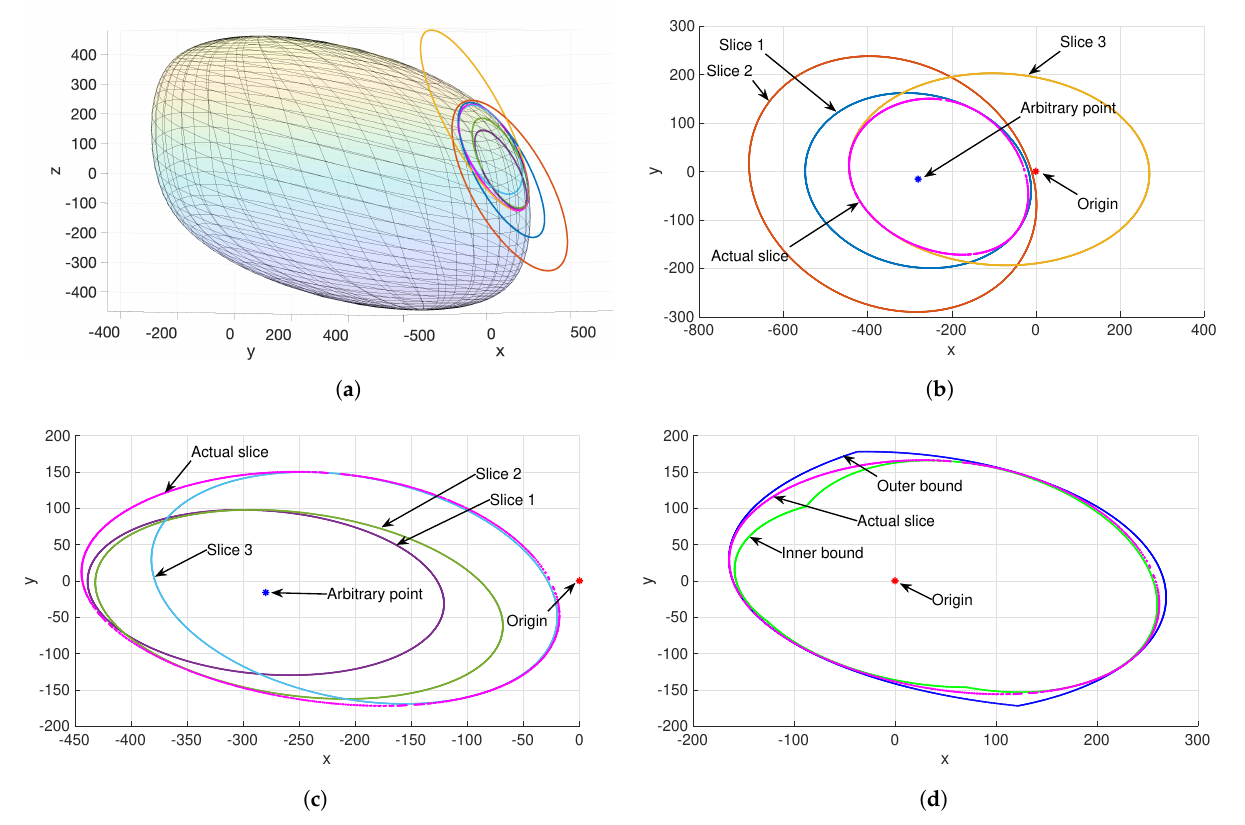
Figure 7. ( a ) Minkowski sum and six slices of Minkowski sum by three outer and three inner bounds of the Minkowski sum and also the actual slice of Minkowski sum, embedded in R 3 . ( b ) Projections of three slices of three outer bounds onto the slicing plane and also the actual slice of Minkowski sum, where slice 1 corresponds to MVOE, slice 2 corresponds to outer Kurzhanski’s with β = λ 1/2 and slice 3 corresponds to outer Kurzhanski’s with β = λ 1/2 max . ( c ) Projections of three slices of three inner bounds onto the slicing plane and also the actual slice of Minkowski sum, where slice 1 corresponds to John’s inner bound, and slices 2 and 3 correspond to inner Kurzhanski’s with two arbitrary S 1 ∈ S + ( 3, R ) . ( d ) Strip for an actual slice of Minkowski sum (pink dotted curve) obtained from the computational algorithm, using the slices of outer and inner bounds in ( b , c ). Note that in subplots ( b ), ( c , d ), the single red point indicates the origin of the coordinate system and the single blue point is an arbitrary point inside the actual slice.